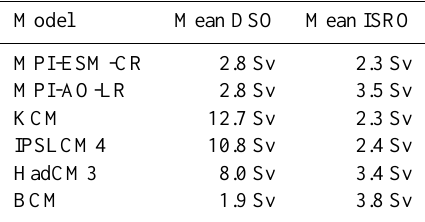
Table 2. Mean value of the overflow transport through the Denmark Strait (DSO) and across the Iceland–Scotland Ridge (ISRO) in the different control